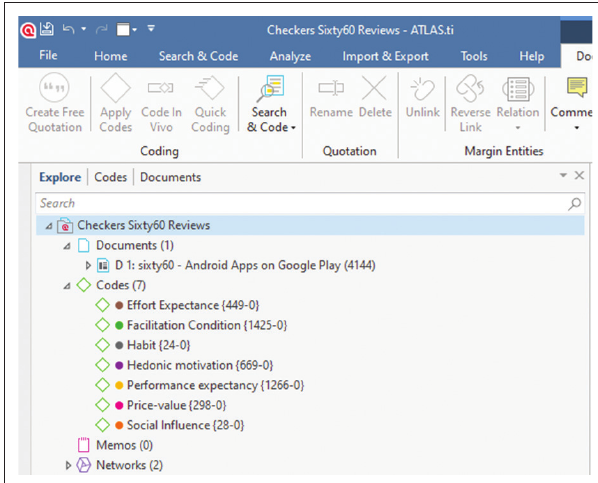
FIGURE 2: Review categories in Atlas. ti